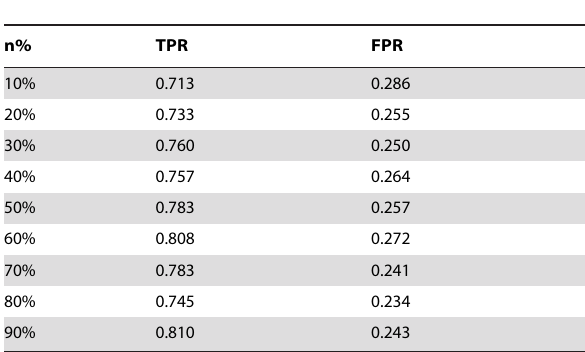
Table 5. Average TPR and FPR in MIHC by